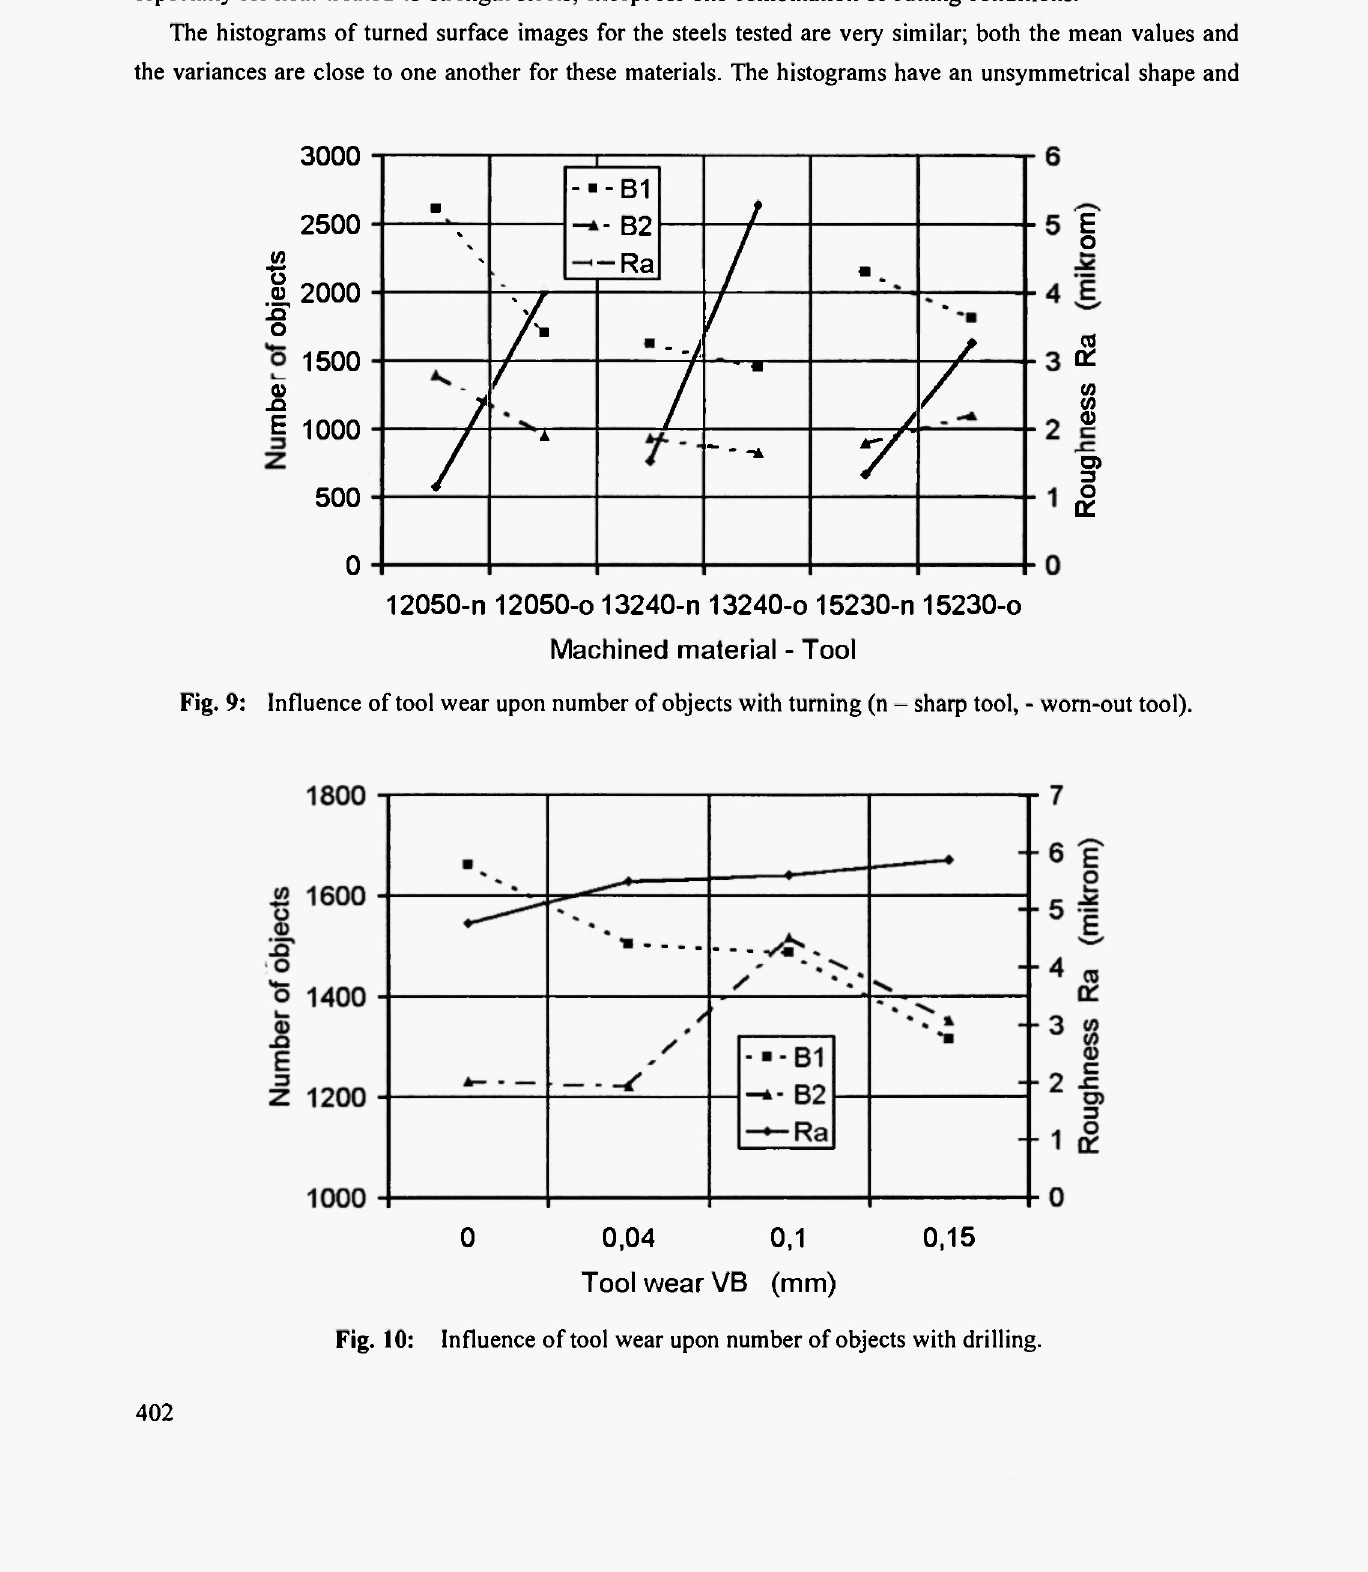
Fig. 10: Influence of tool wear upon number of objects with